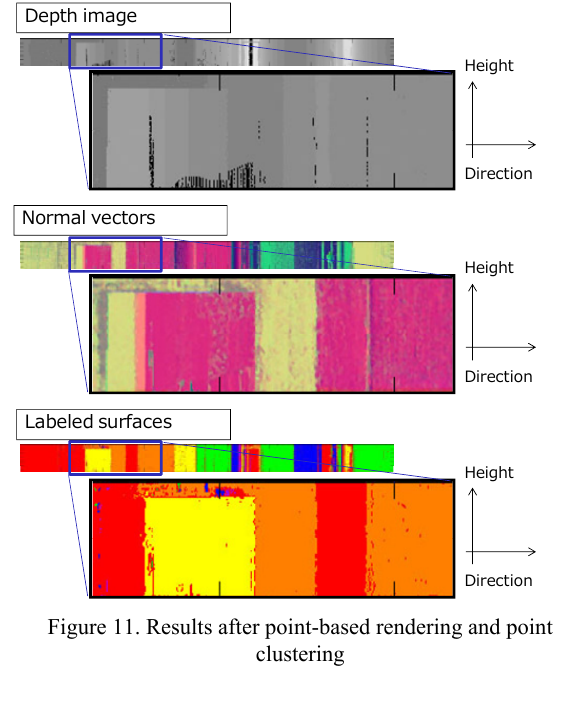
Figure 11. Results after point-based rendering and point